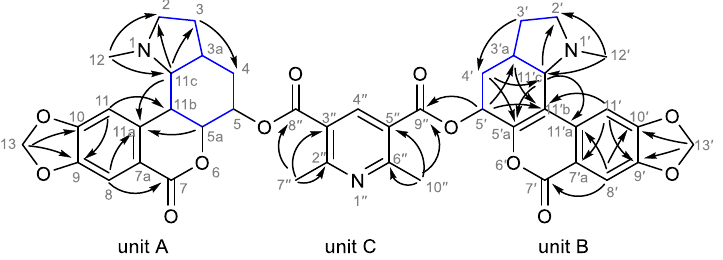
Figure 3. Key 2D NMR correlations for 3 —HMBC (arrows), COSY, and H2BC (blue bonds). Table 1. 1 H NMR (499.9 MHz) and 13 C NMR (125.7 MHz) data for 3 analyzed in C 5 D 5 N ( δ in ppm and J in Hz).